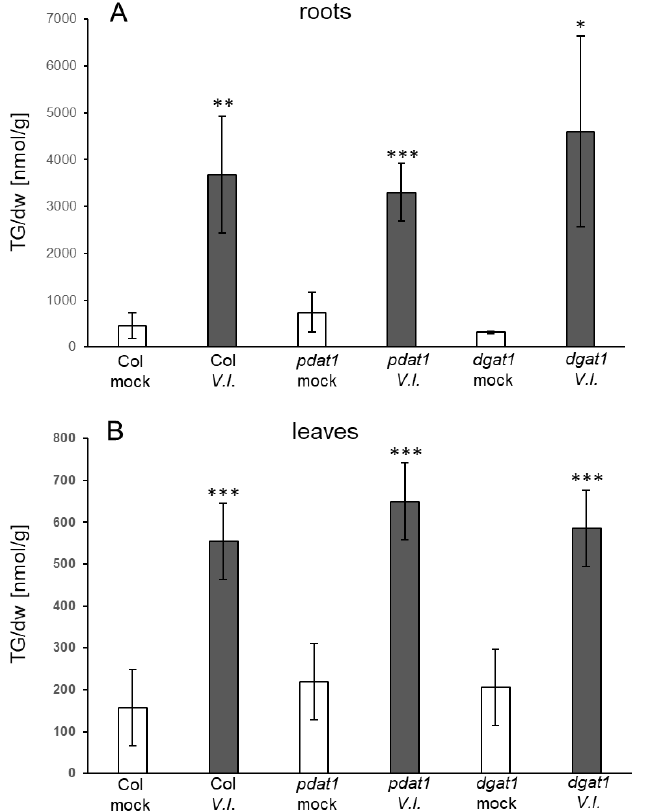
Figure 3. Accumulation of TGs in ( A ) roots and ( B ) leaves of Col-0, pdat1-2 and dgat1-1 plants in response to treatment of roots with V.l. (dark grey bars) or mock (white bars) at day 3. Shown is the mean of five biological replicates ± sd of the sum of TGs [nmol/g dry weight] with 52 and 54 acyl carbon atoms and one to nine double bonds. Asterisks indicate significant differences between the V.l. treated samples and the corresponding mock treated sample (* p < 0.05; ** p < 0.01; *** p < 0.001). There was no significant difference between the mutant lines and the wild type in the corresponding samples.